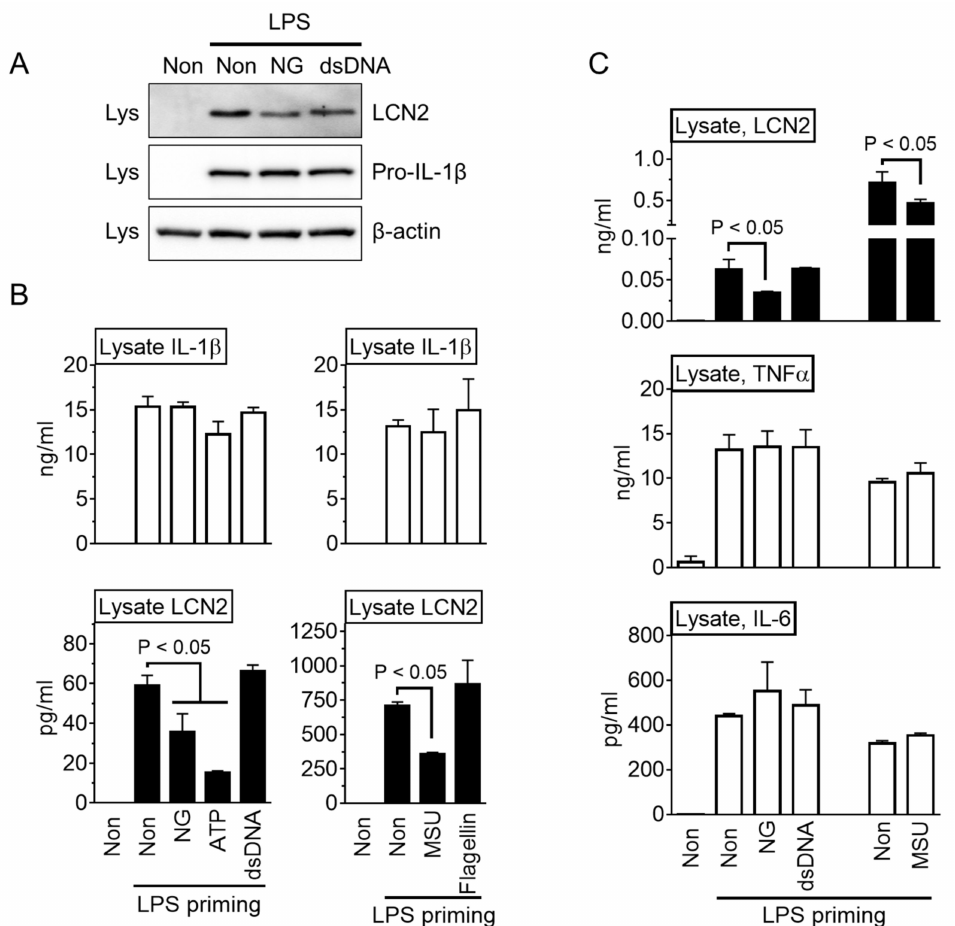
Figure 4. Effect of NLRP3 triggers on cytosolic LCN2 levels. ( A ) BMDM were primed with LPS and then treated with NG or dsDNA. The cellular lysates were subjected to immunoblotting as indicated. ( B ) LPS-primed BMDM were treated with an inflammasome trigger as indicated, and then the cellular lysates were analyzed by IL-1 β or LCN2 ELISA. ( C ) LPS-primed BMDM were treated with inflammasome triggers as indicated, and the levels of IL-1 β , TNF α , and IL-6 in the lysate were measured. The bar graph shows the mean ± SD of at least two independent